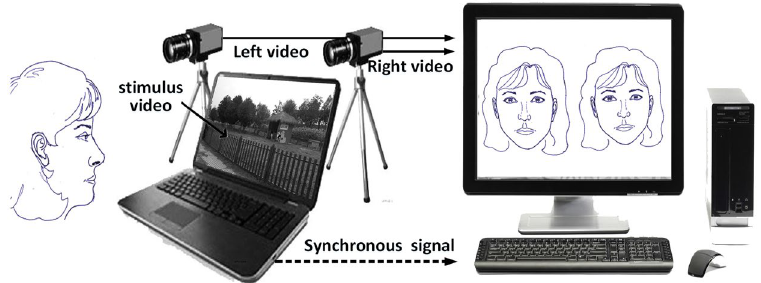
Figure 1. An experimental layout for expression induction, capture and